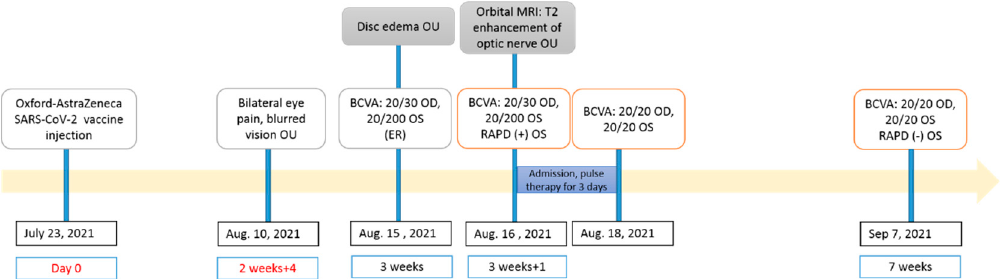
Figure 2. The timeline of our patient’s clinical presentation.